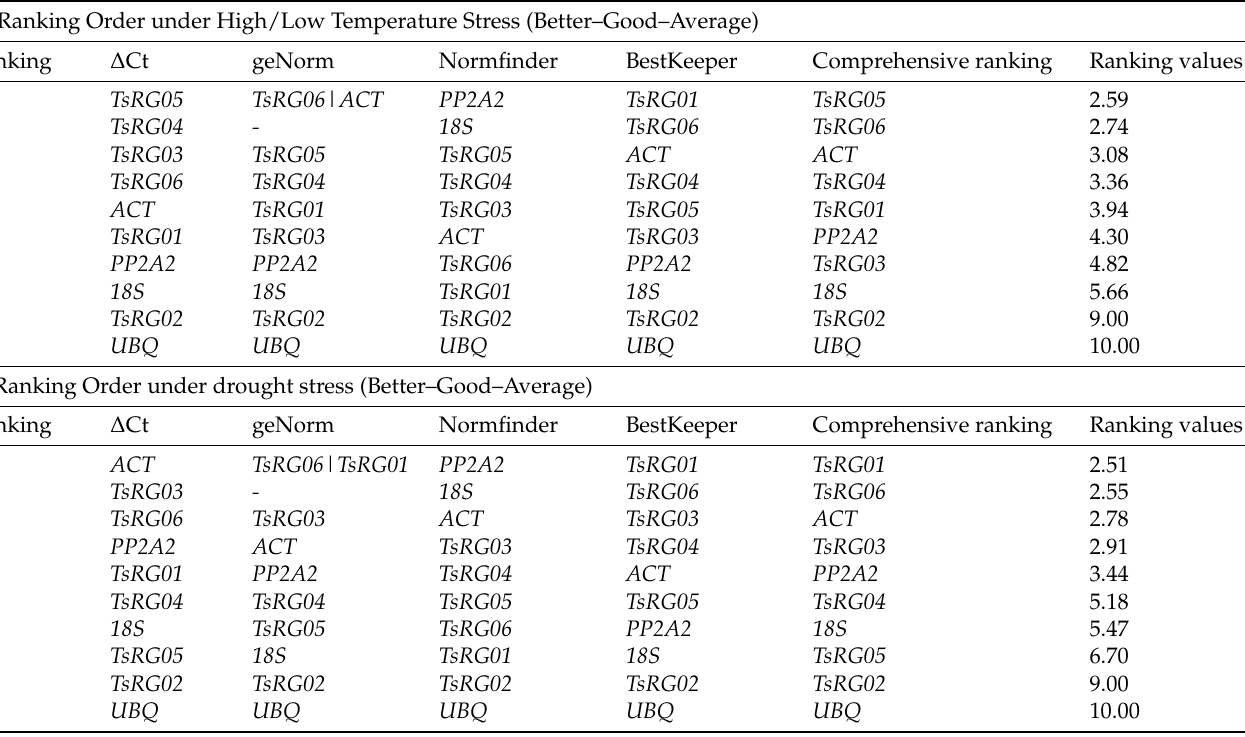
Table 5. The stability ranking order of 10 candidate RGs were calculated by